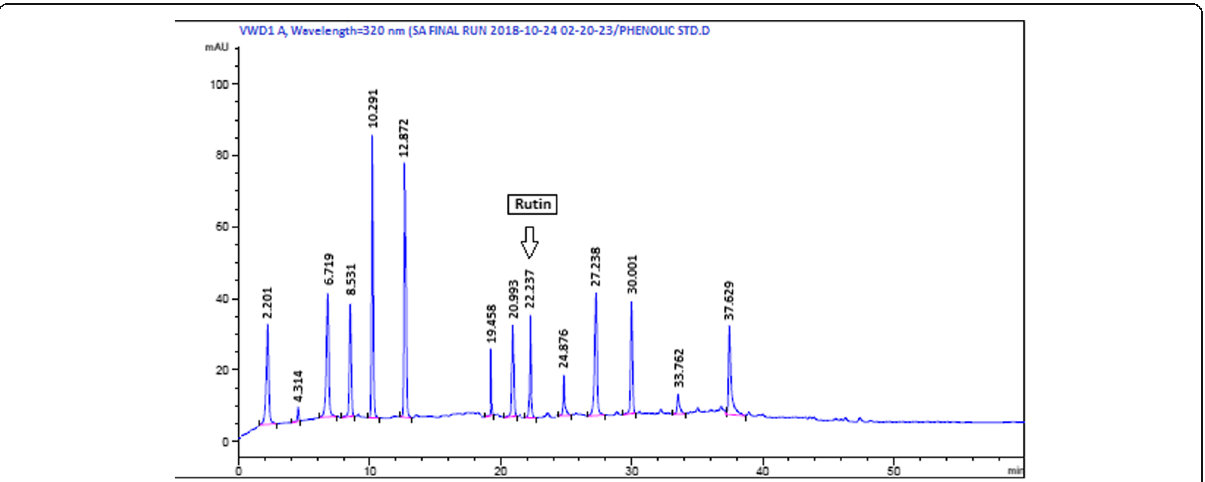
Fig. 3 HPLC- DAD profiling of Atriplex lasiantha methanol: ethyl acetate extract (AMEA) at different wavelength. Only rutin was detected at 257 nm. Conditions: Mobile Phase A (methanol: acetic acid; deionized water, 100: 20: 180, v /v) and Mobile Phase B (methanol: acetic acid: deionized water, 900: 20: 80,v/v). The flow rate was kept at 1 ml/min. The gradient volume of B was utilized as follows: 0 – 50% in 0 – 20 min, 50 – 100% in 20 – 25 min and then 100% from 25 to 30 min. The absorption of samples was recorded at different wavelengths e.g. Gallic acid at 257 nm, catechin at 279 nm, Rutin at 257 nm, caffeic acid at 325 nm and kaempferol, quercetin, myricetin at 368 nm, but only rutin was detected